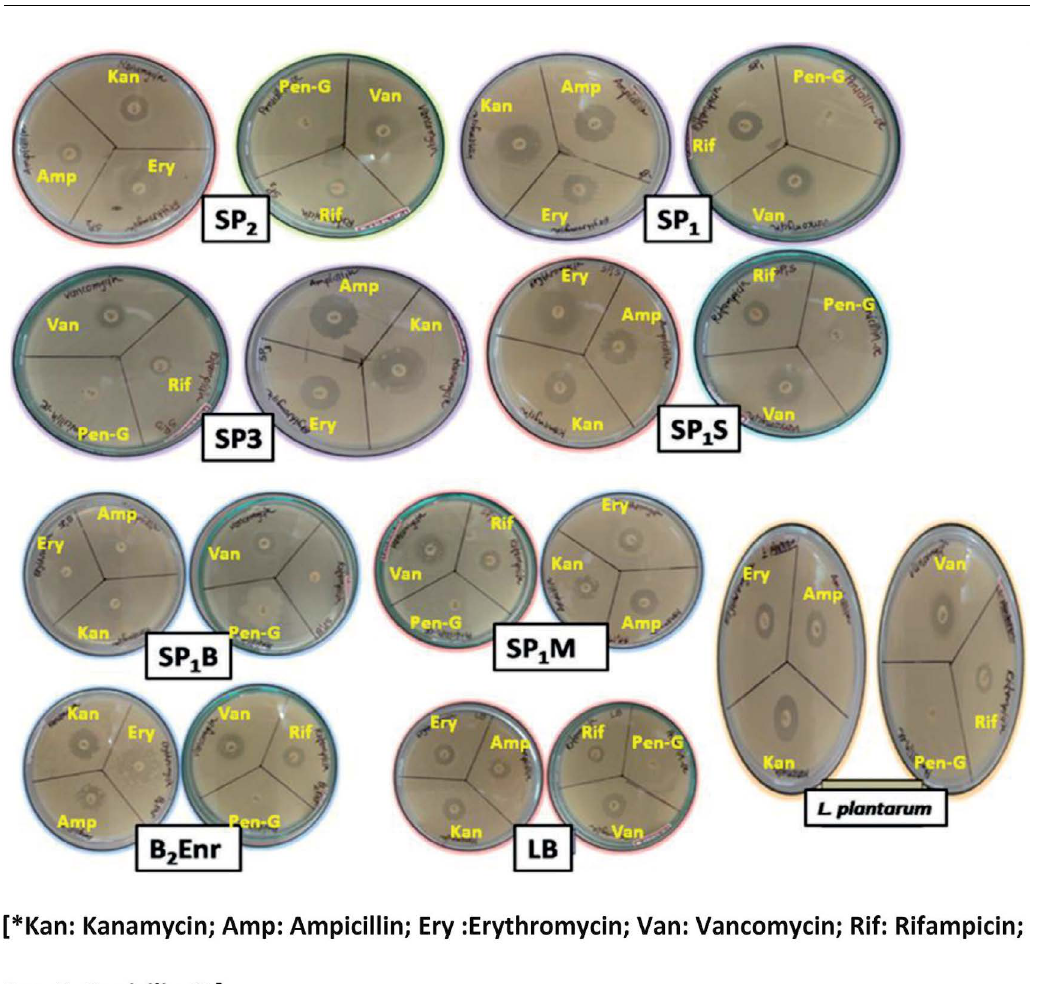
Fig. 3. Antibiotic resistance of probiotic isolates shown on Muller Hinton Agar plates. All the probiotic isolates were resistant to Penicillin-G antibiotic. The probiotic isolates were susceptible to Kanamycin, Erythromycin, Vancomycin, Ampicillin, Rifampicin